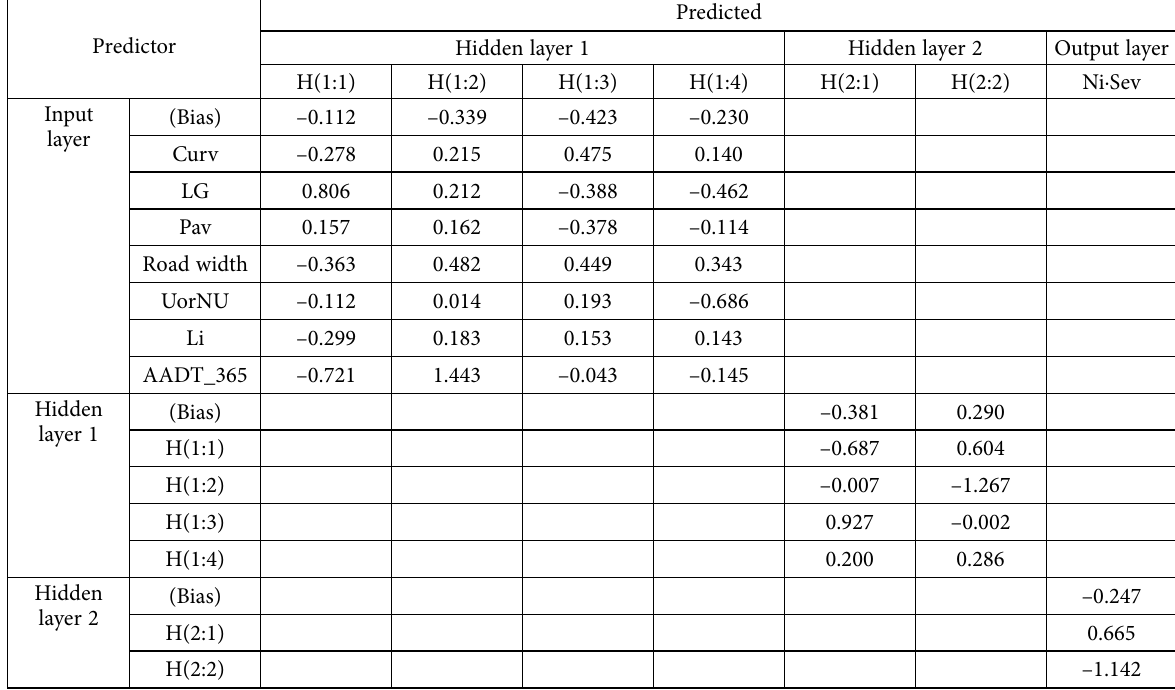
Table 6. Parameters of the ANN